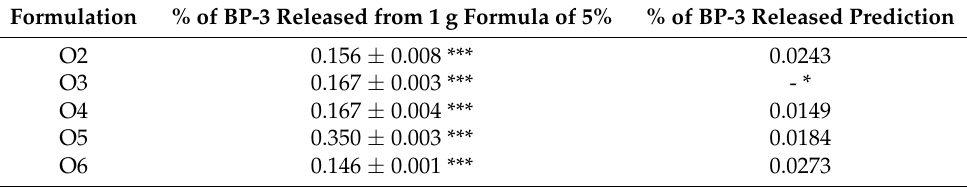
Table 8. Release rates obtained from Franz cells and predicted by the software by the different oil formulations: O2 (Dicaprylyl Carbonate); O3 (Cocogliceride); O4 (Caprilic-Capric Triglyceride); O5 (Dicaprylyl Ether); O6 (C12-C15 Alkyl Benzoate). Each value was obtained from four experiments (mean ± SE). *** p < 0.0001. Formulation % of BP-3 Released from 1 g Formula of 5% % of BP-3 Released Prediction O2 0.156 ± 0.008 *** 0.0243 O3 0.167 ± 0.003 *** - * O4 0.167 ± 0.004 *** 0.0149 O5 0.350 ± 0.003 *** 0.0184 O6 0.146 ± 0.001 ***